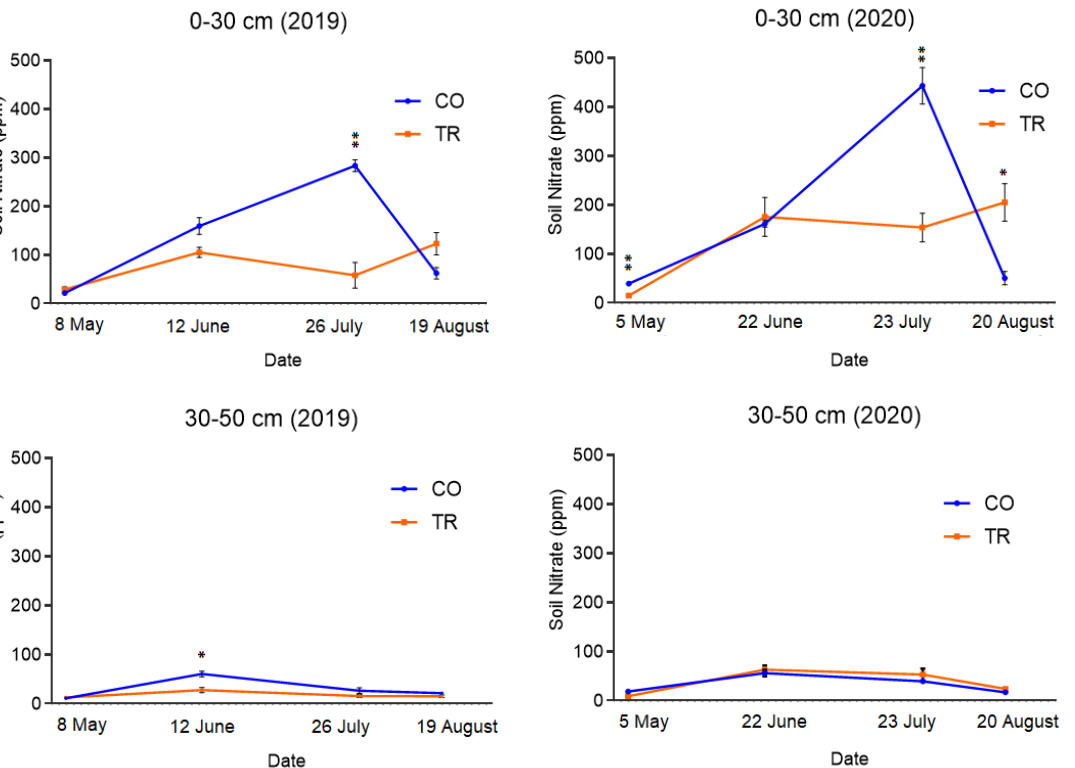
Figure 2. Nitrate content (ppm) in the two soil layers, 0–30 cm and 30–50 cm for the TR (with CC) and CO (without CC) systems in 2019 and 2020 years. Vertical bars represent the standard error (* = p < 0.05 and ** = p < 0.01).